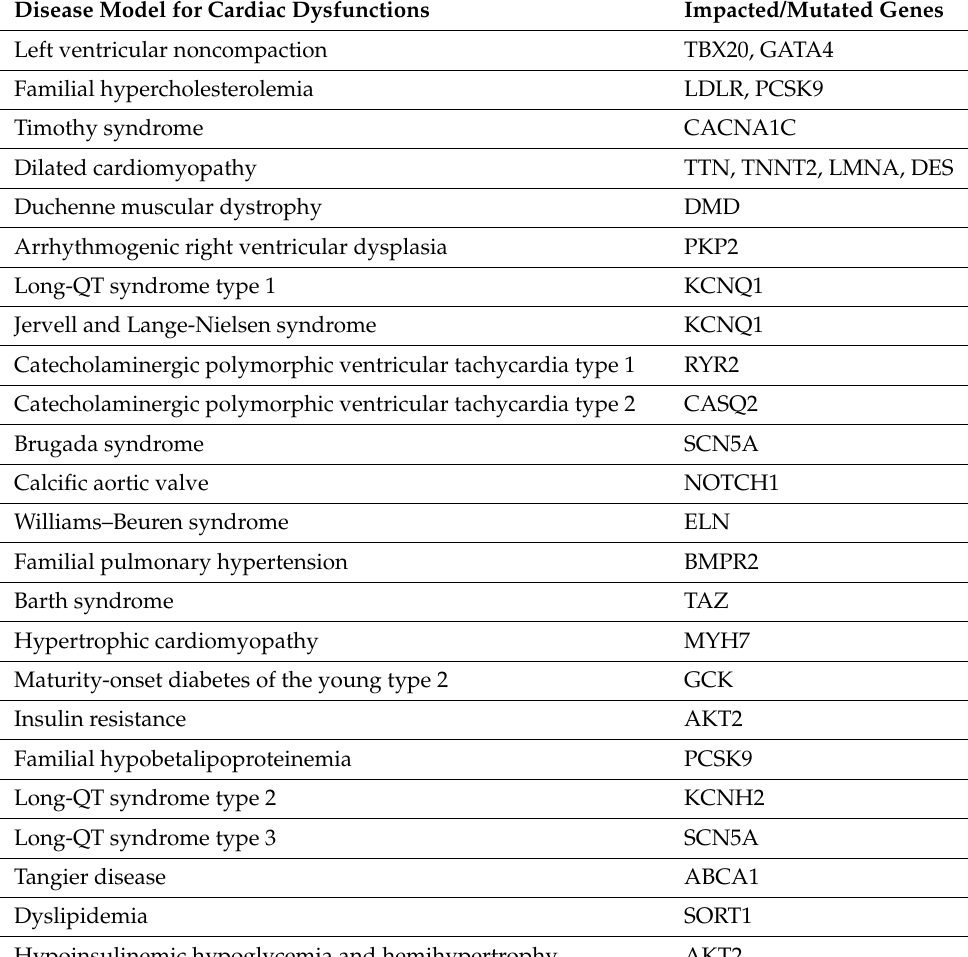
Table 2. List of cardiovascular diseases modeled with human iPSCs or ESCs. Disease Model for Cardiac